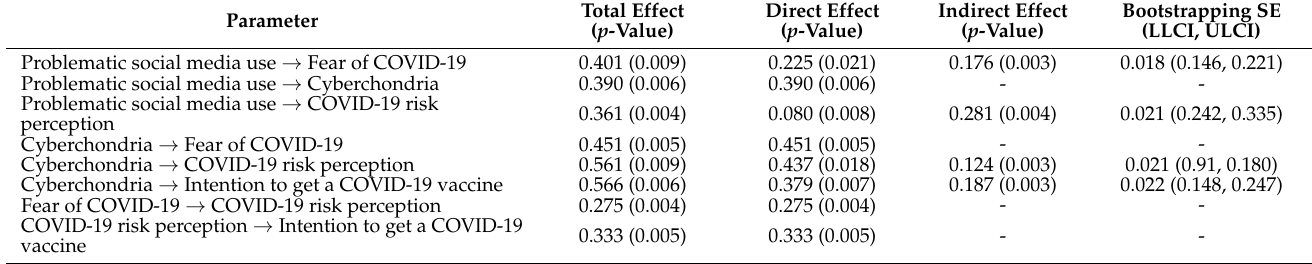
Table 3. Direct, indirect, and total standard effects of the statistically significant associations between the study variables. The analyses were adjusted for age, sex, marital status, education, and area of residence.